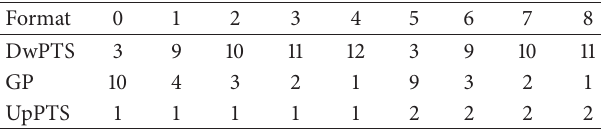
Table 1: DwPTS/GP/UpPTS length in a special subframe (OFDM symbols, normal CP).